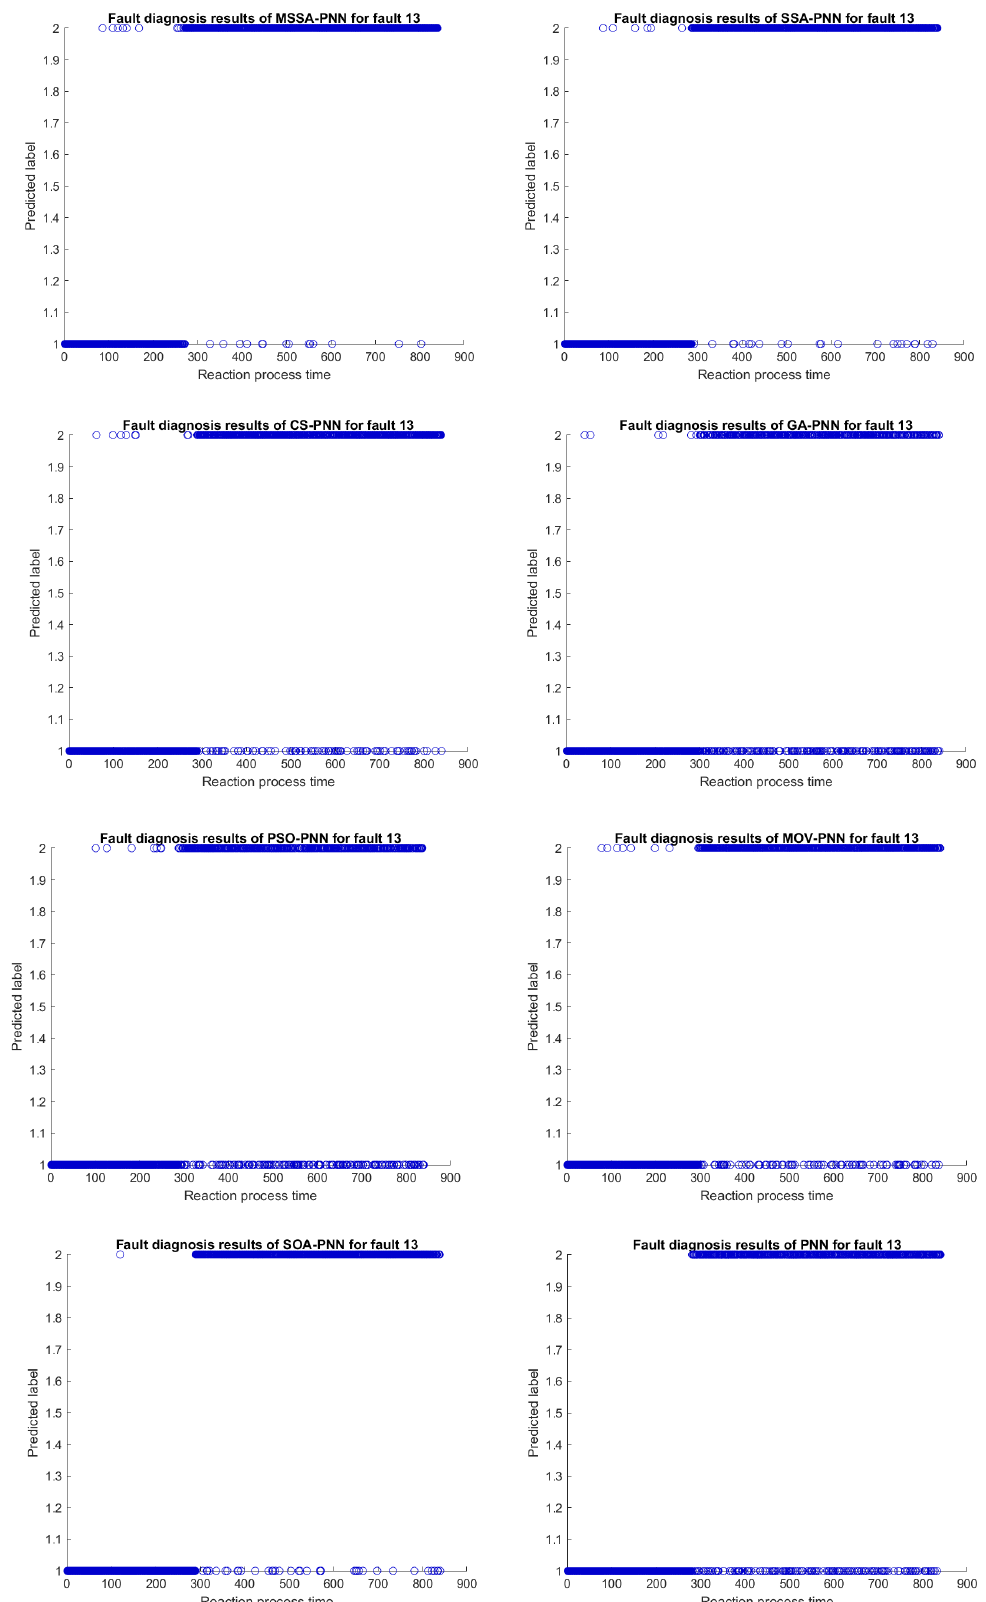
Figure 7. Monitoring performances for Fault